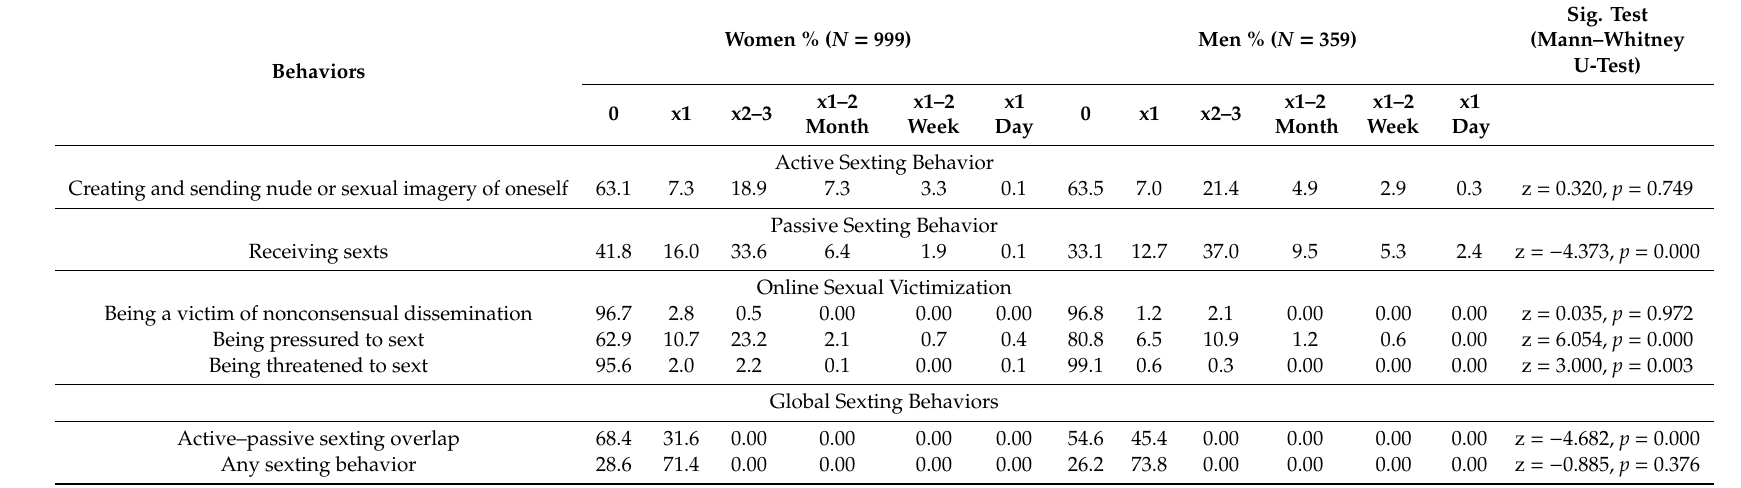
Table 3. Distribution of frequencies of sexting behaviors in percentages by